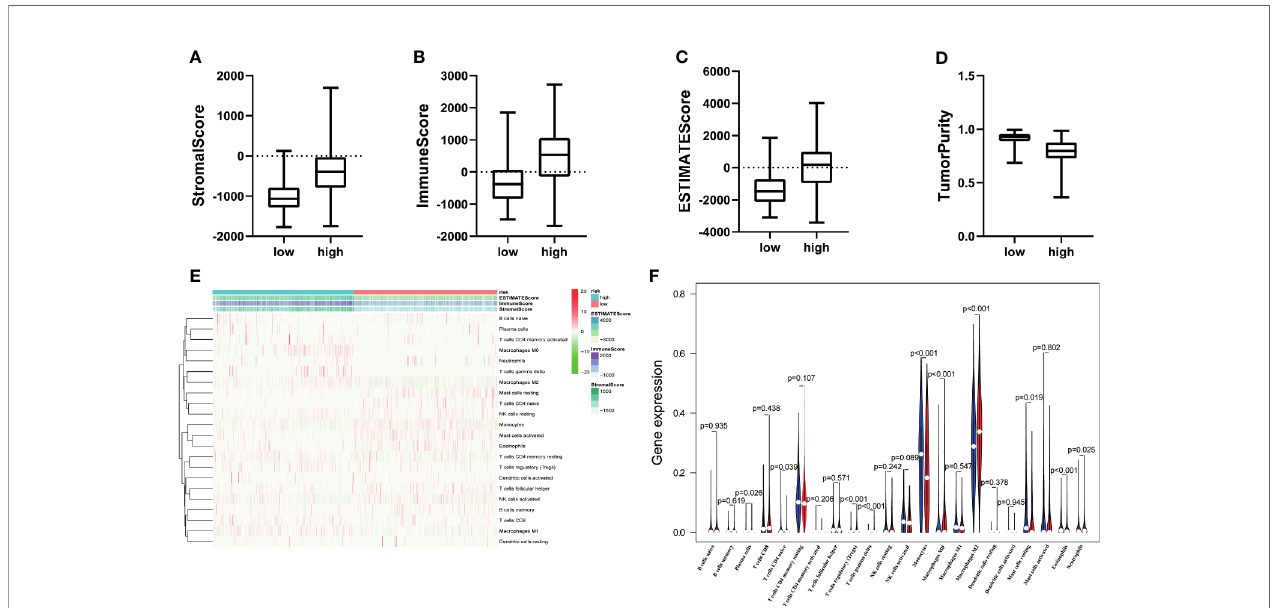
FIGURE 6 | The landscape of immune in fi ltration and estimating tumor purity. (A – D) There is a statistical difference of the stromal score (A) immune score (B) ESTIMA TE score (C) and Tumor Purity (D) between the high- and the low-risk groups. (E) The heatmap shows the stromal score immune score, ESTIMATE score and corresponding 22 immune cell proportions of each glioma patient in the two risk groups. The horizontal axis shows the samples which were divided into two risk groups. (F) The violin plot revealed the distribution of same immune cells between two risk groups. (Blue was low-risk group and red was high-risk